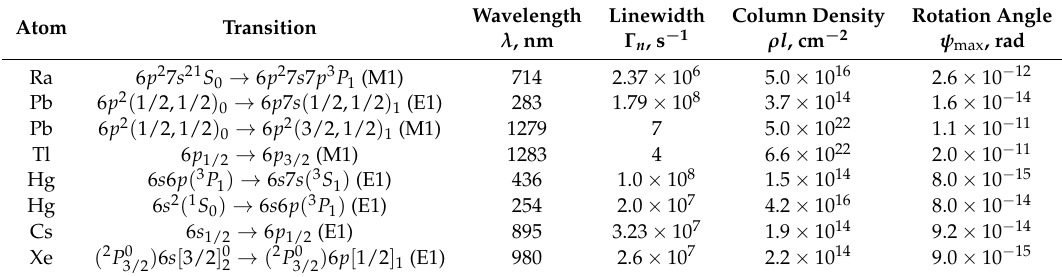
Table 1. The summary of the results of the P , T -odd Faraday optical rotation theoretical simulation for different atomic species. The maximum P , T -odd Faraday rotation angle ψ max (in rad) corresponds to an external electric field E = 10 5 V/cm [10] and to the present e EDM bound established in experiments with ThO molecules ( d e = 10 − 29 e cm